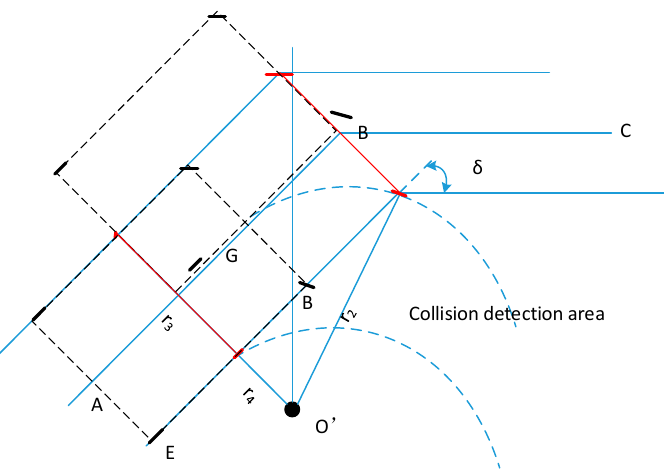
Figure 7. Schematic diagram of the path offset process.